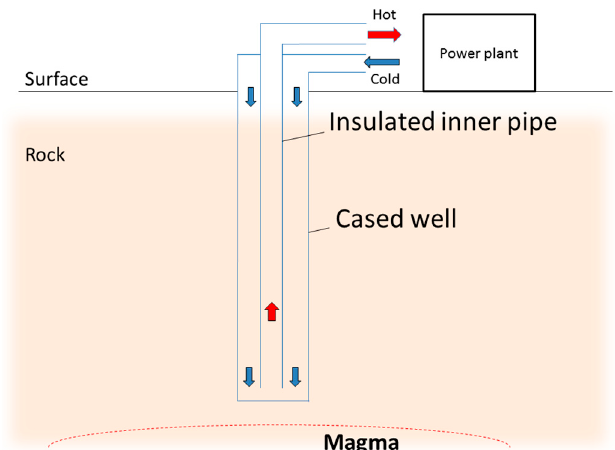
Figure 1. Schematic of the downhole borehole heat exchanger concept set in Hawaii above a magmatic intrusion (modified from [13]).